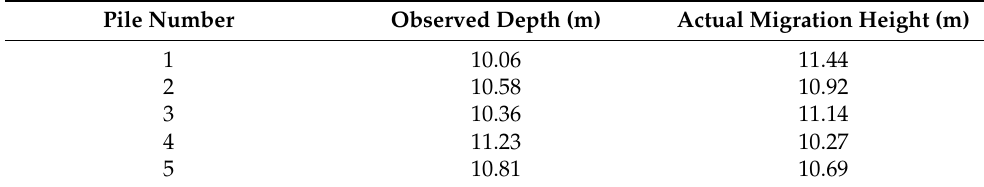
Figure 4. Formation of construction site and layout of grouting pipes. Table 2. First observed depth of cement slurry for 5 bored piles.